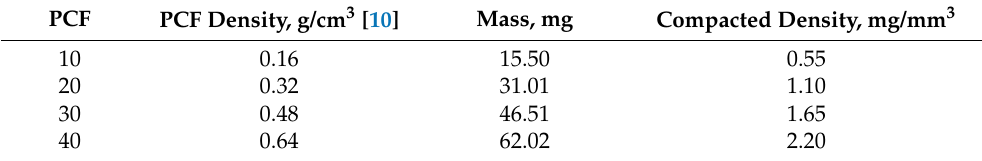
Table 1. Calculated values for chosen PCF